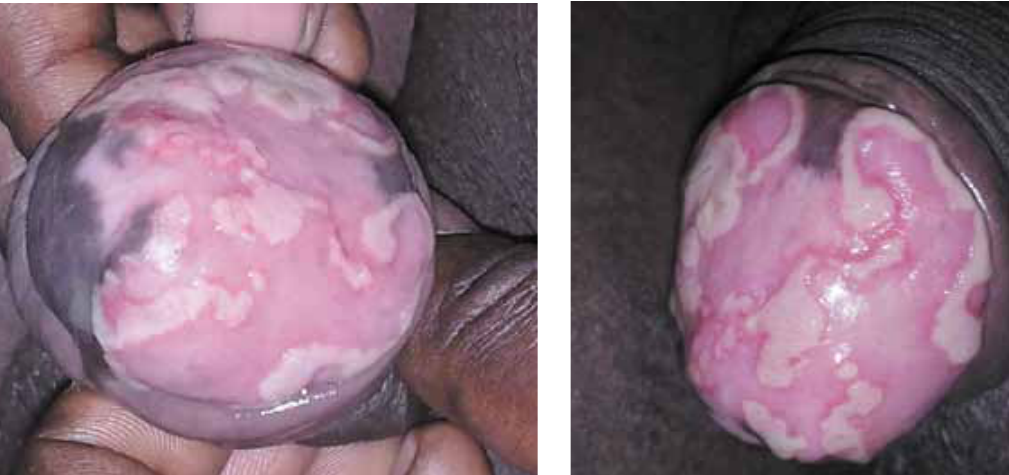
Fig. 1. Ulceration and yellow penile urethral discharge. Fig. 2. Ulceration involving entire